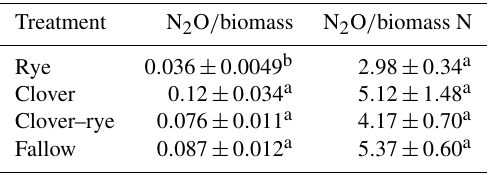
Table 5. Mean ± standard error for ratios of grams of N 2 O to kilo- grams of cover crop biomass and grams of N 2 O to kilograms of cover crop biomass N averaged across both sites by treatment. Sig- nificant treatment differences are indicated by different